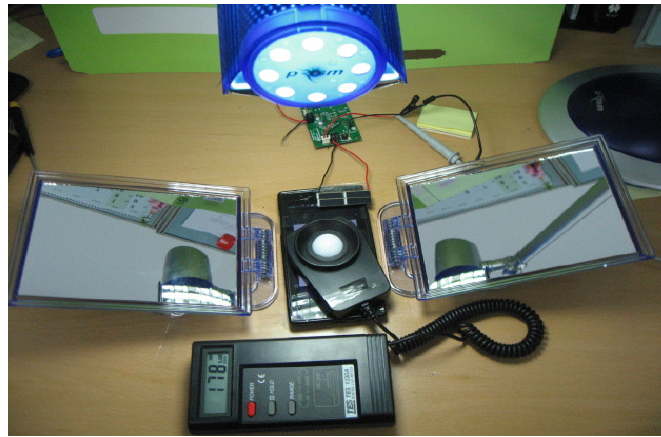
Figure 5. A comparison of smartphone internal ALS data vs. light meter data.